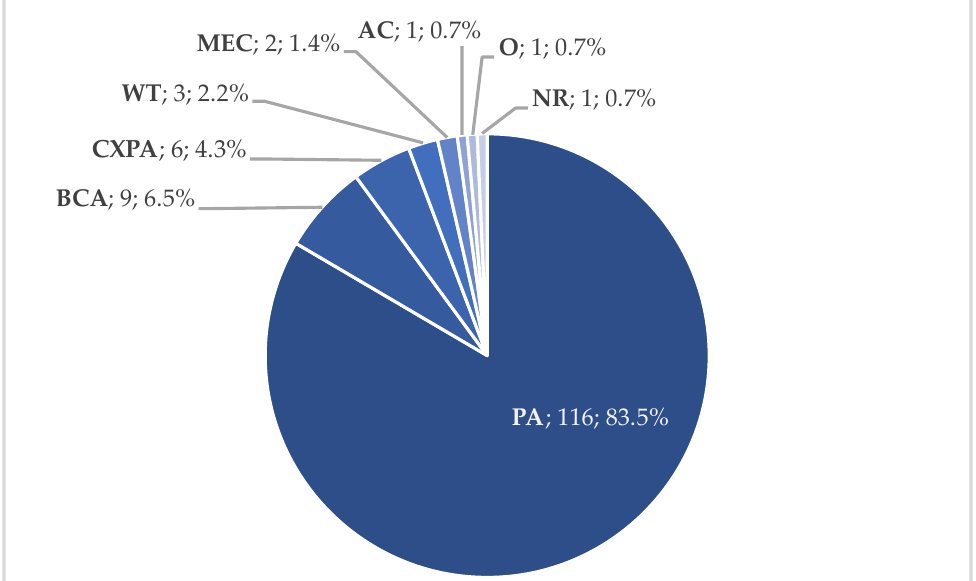
Figure 3. Tumor histology in transoral approach ( n , %). Abbreviations: AC, adenocarcinoma; BCA, basal cell adenoma; CXPA, carcinoma ex pleomorphic adenoma; MEC, mucoepidermoid carcinoma; NR, not reported; O, oncocytoma; PA, pleomorphic adenoma; WT, Warthin tumor.